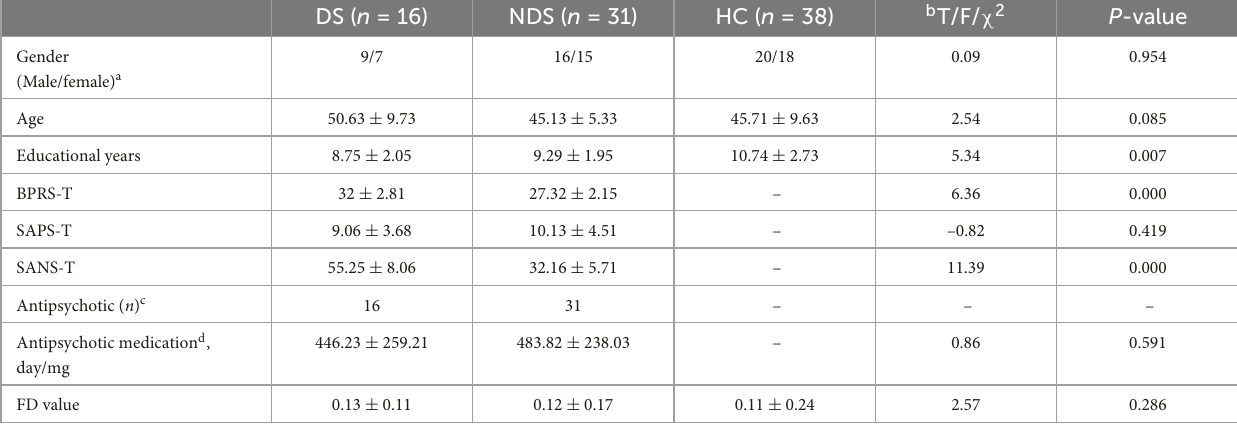
TABLE 1 Demographic and clinical